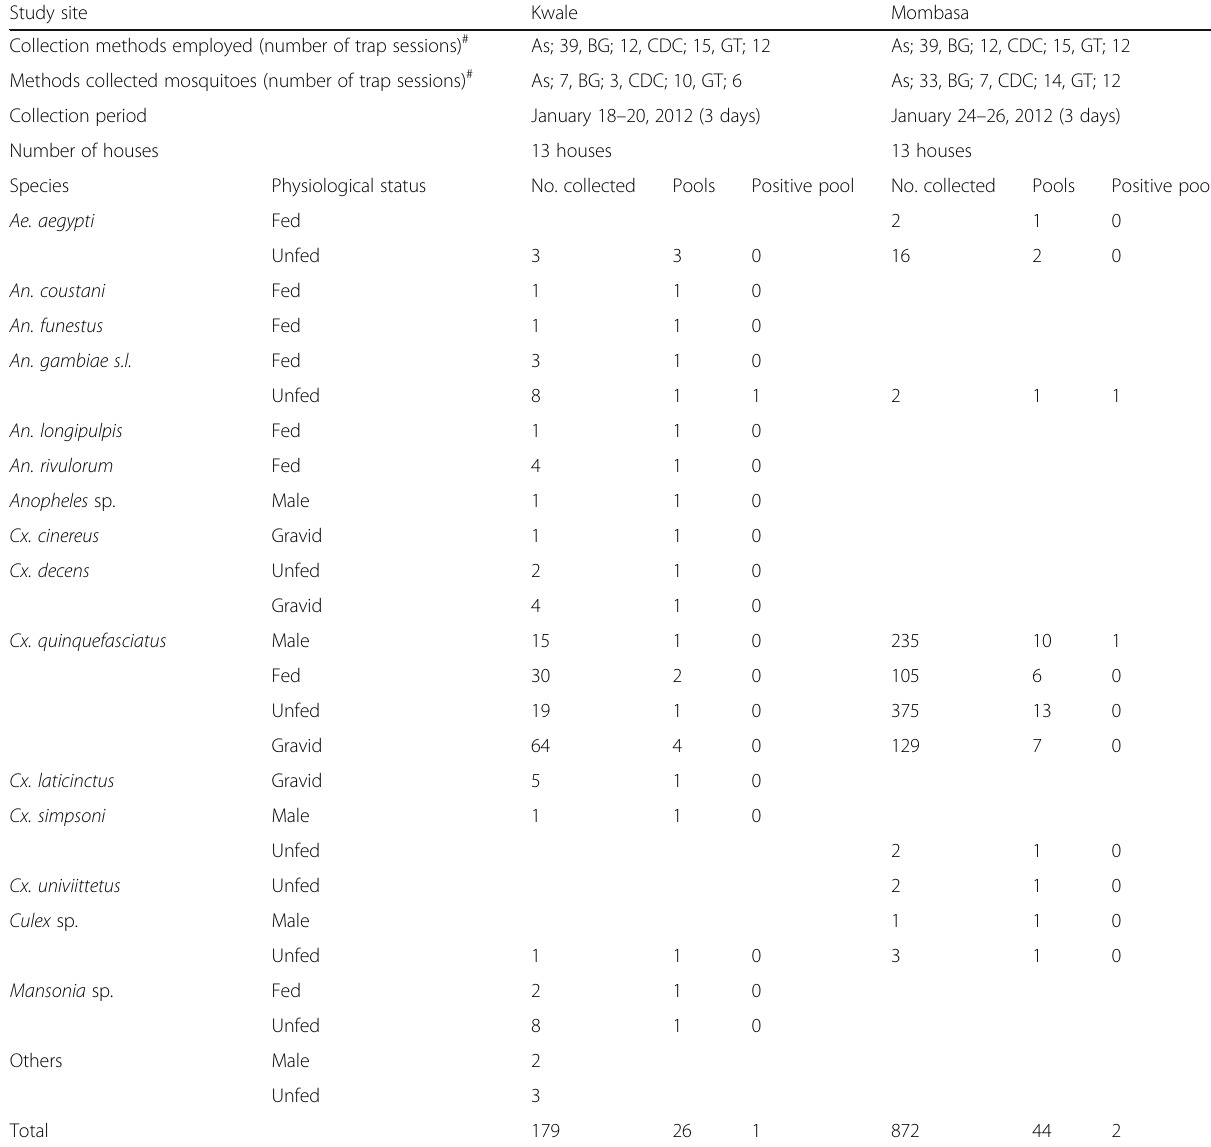
Table 2 Summary of mosquitoes collected in the dry season in East Kenya Study site Kwale